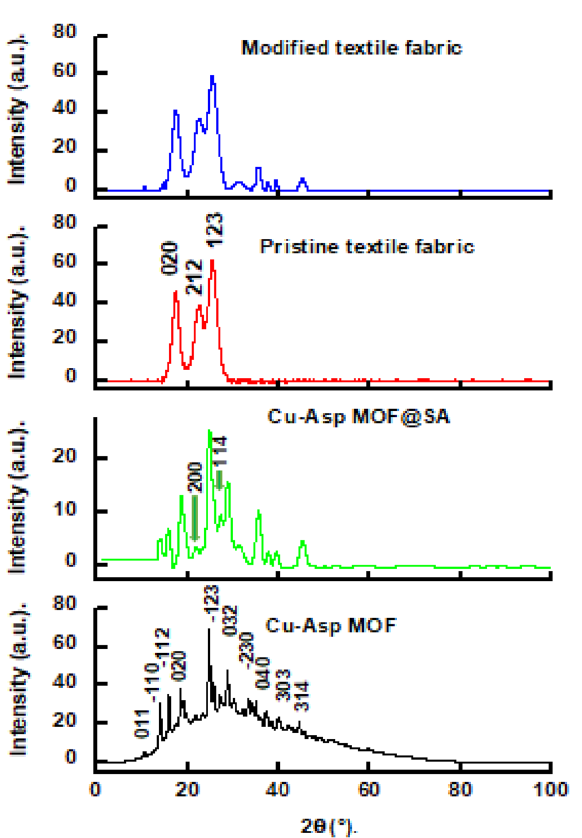
Figure 3. XRD pattern of Cu-Asp MOF, Cu-Asp MOF@SA, pristine textile fabric, and modified textile